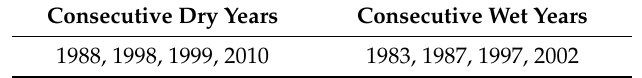
Table 2. The consensus years of strong and very strong El Niño (La Niña) as outlined in